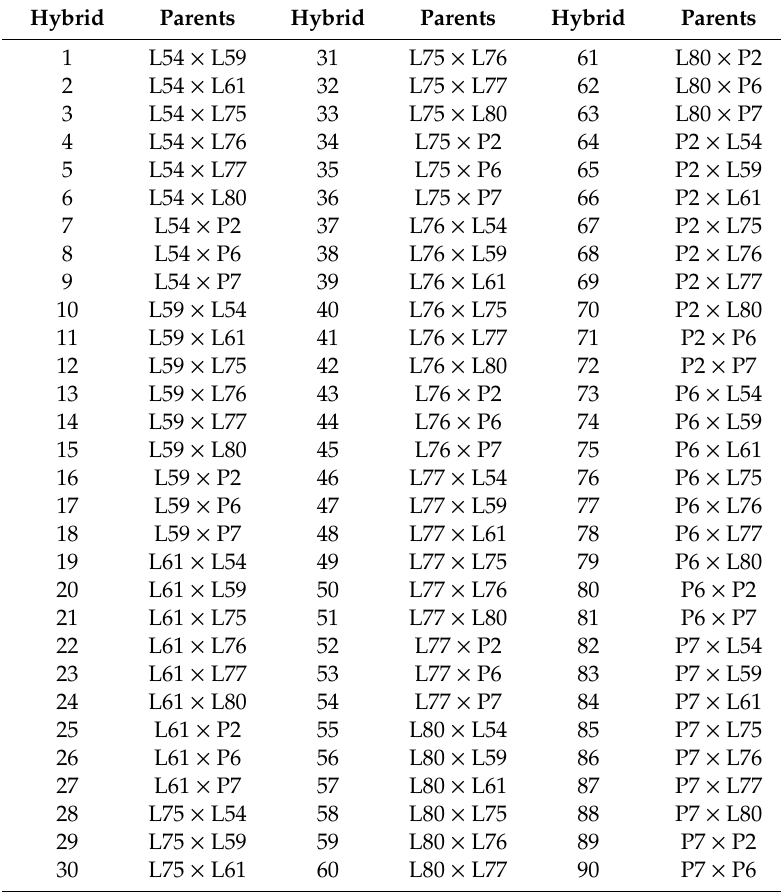
Table 2. Identification of the 90 hybrids and their respective parents used in the